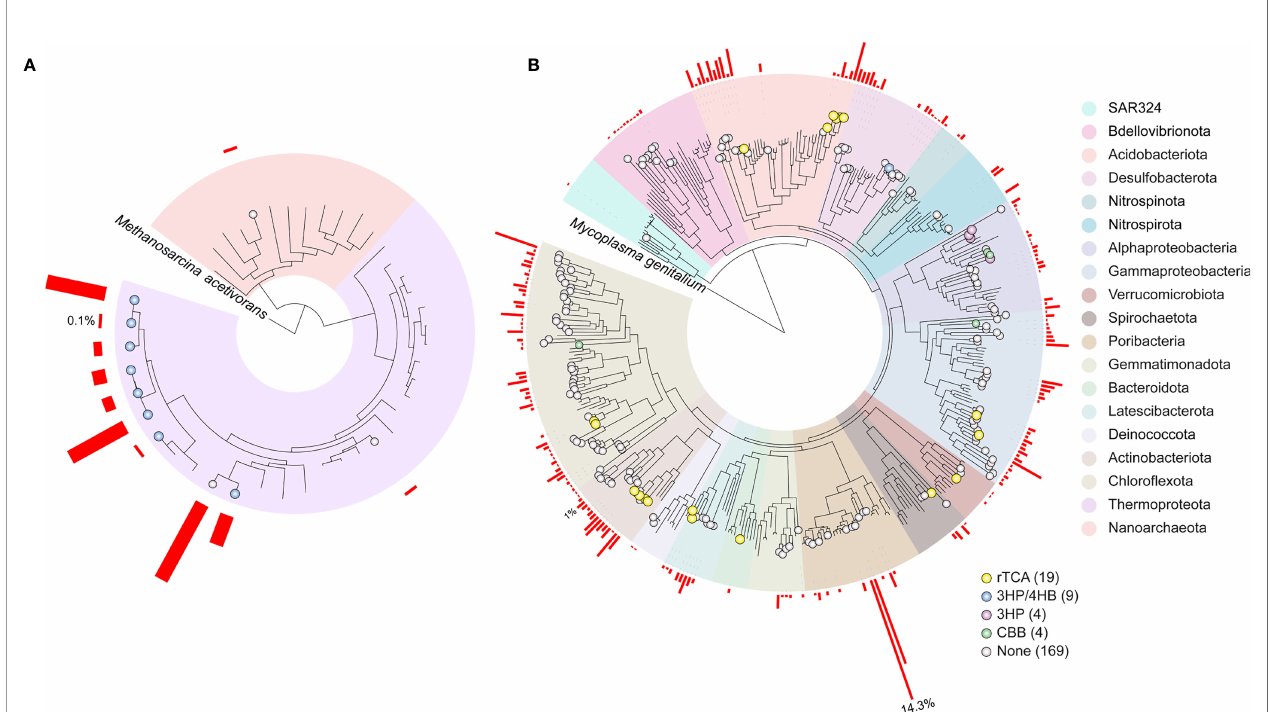
FIGURE 4 | Phylogeny of metagenome-assembled genome (MAGs) in GARS. (A) Archaea MAGs phylogeny, (B) Bacteria MAGs phylogeny. The bacterial and archaeal trees are rooted to Methanosarcina acetivorans (RS_GCF_000007345.1) and Mycoplasma genitalium (RS_GCF_000027325.1), respectively. MAGs related to carbon fi xation pathways are shown with circles: Reductive tricarboxylic acid (rTCA), yellow; Calvin – Benson – Bassham cycle (CBB), green; 3-Hydroxypropionate/4- hydroxybutyrate (3HP/4HB), blue; 3-Hydroxypropionate bicycle (3HP), purple. MAGs that did not meet the chosen METABOLIC carbon fi xation cut-off are marked in grey (none). The number of MAGs in each carbon fi xation pathway is shown in parentheses. Phylogeny of the MAGs is shaded by phylum, Proteobacteria were split into classes. The red bars next to each MAG represents the its abundance coverage (%) in the GARS sponge